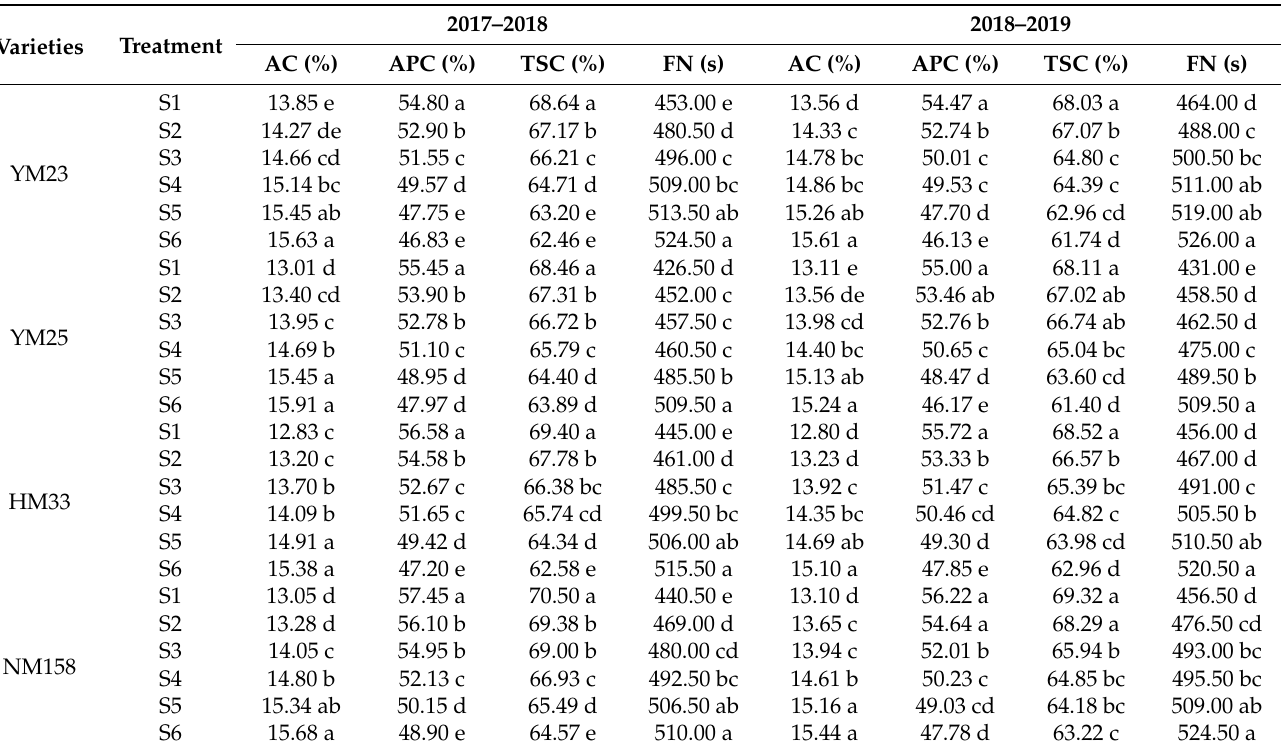
Figure 9. Change in daily mean solar radiation (R mean ) after anthesis on different sowing dates. Table 1. Effects of temperature and radiation on grain starch content and falling